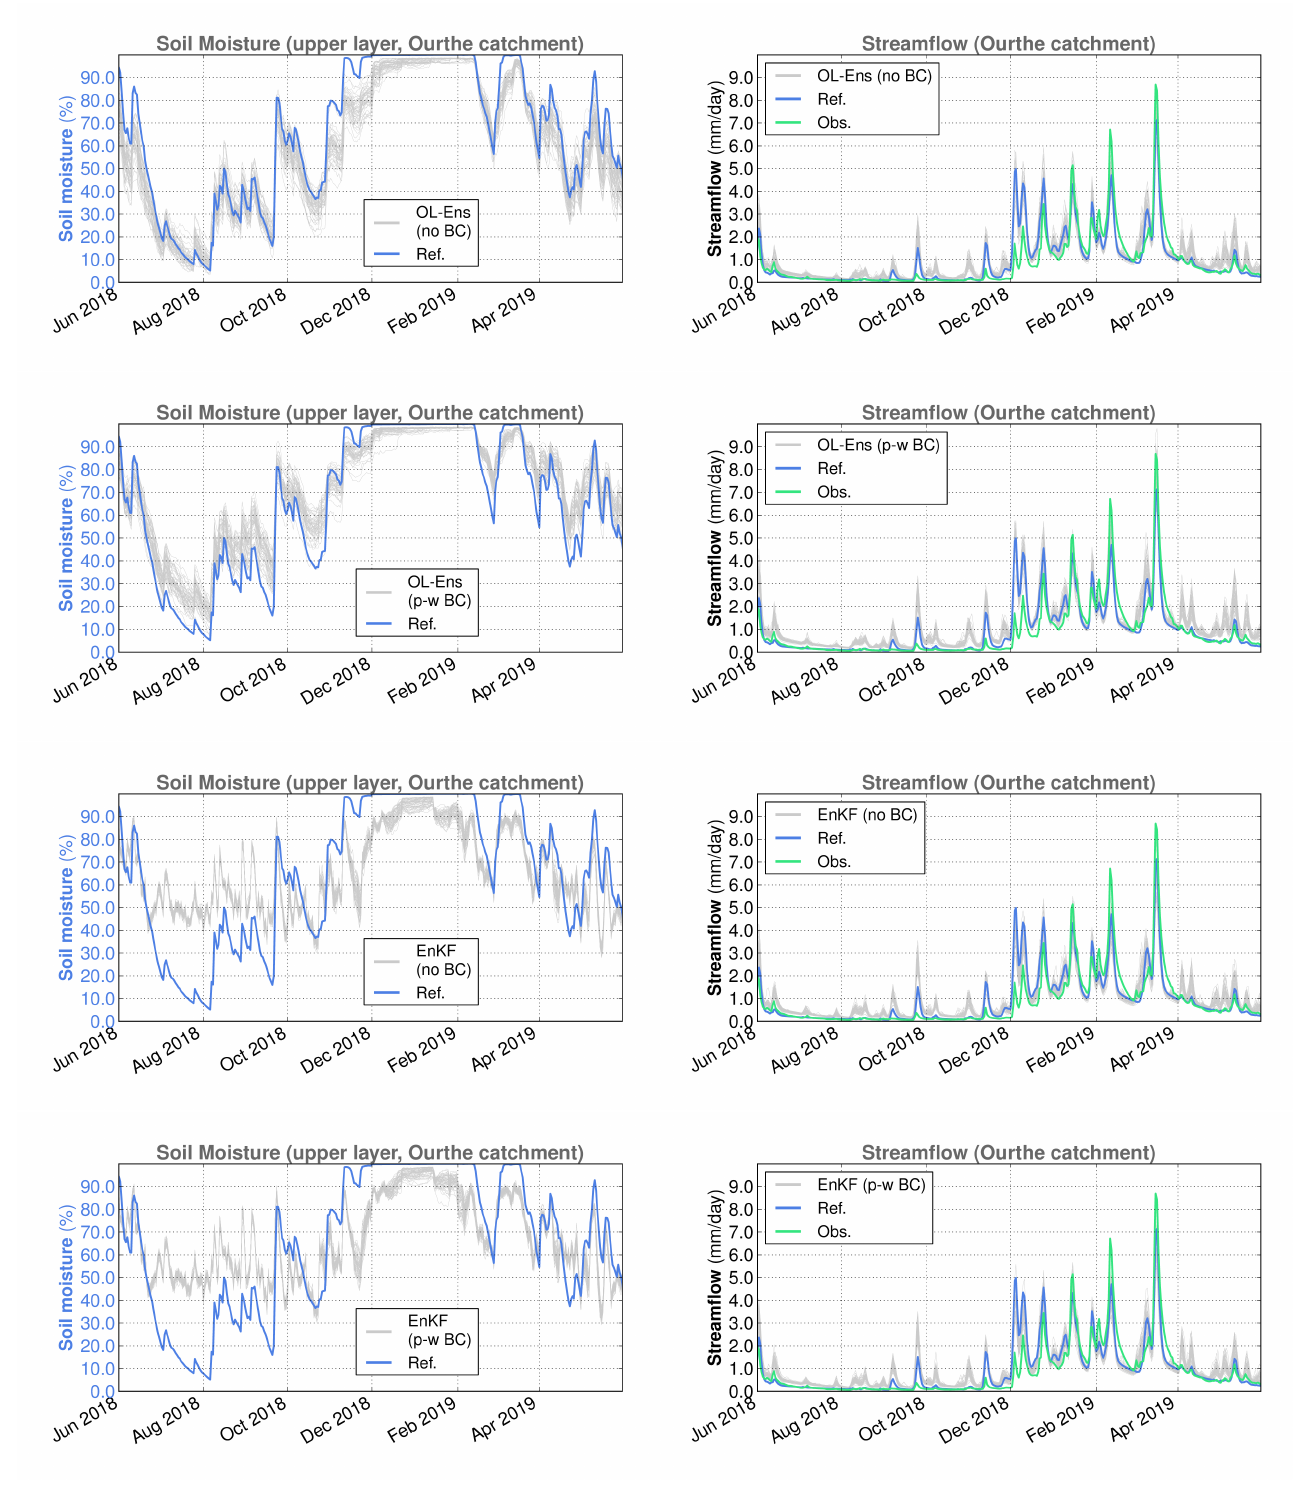
Figure 11. Spatially averaged surface soil moisture (reference simulation and ensemble members) and streamflow (reference simulation, observations and ensemble members) for the Ourthe catch- ment in SCHEME model simulations, June 2018–May 2019. From top to bottom: OL without bias correction, OL with piece-wise bias correction, EnKF without bias correction, EnKF with piece-wise bias